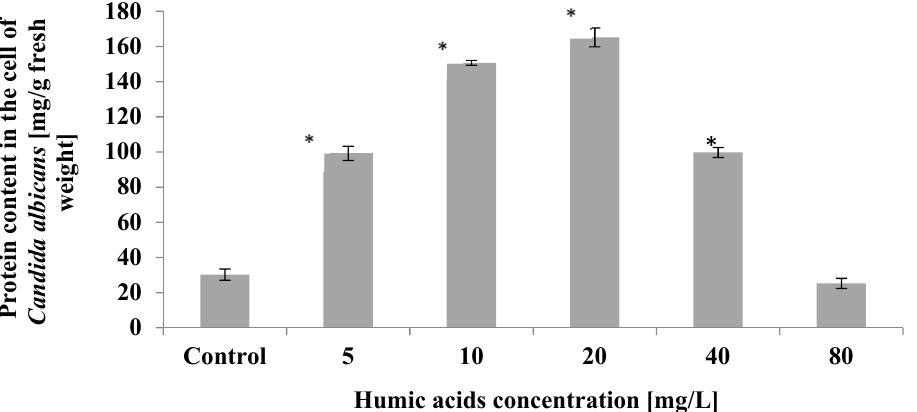
Figure 2. The effect of humic acids on protein content in cell of Candida albicans on the 5th day of culture ( n = 8, average values ± SD, p ≤ 0.01), (*) shows statistically significantly different values in comparison with control sample.